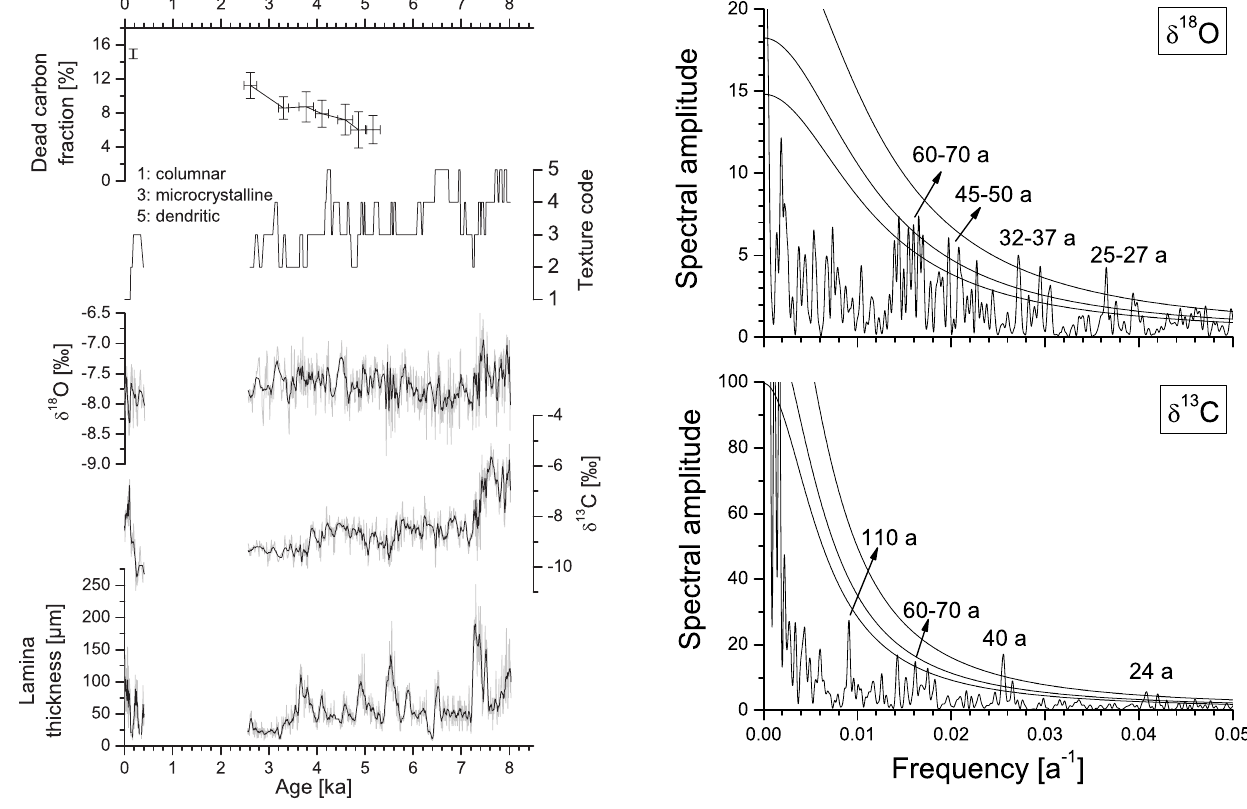
Fig. 3. Comparison of the different proxies measured on stalagmite ER 76. All data are shown on the lamina-counting age model. Val- ues of dead carbon fraction are shown with 1 σ -error bars. The tex- ture code has been taken from McDermott et al. (1999) and adjusted to the new age scale. Stable isotope and lamina thickness data are shown in light grey, and the solid lines are the corresponding 10- point running means.